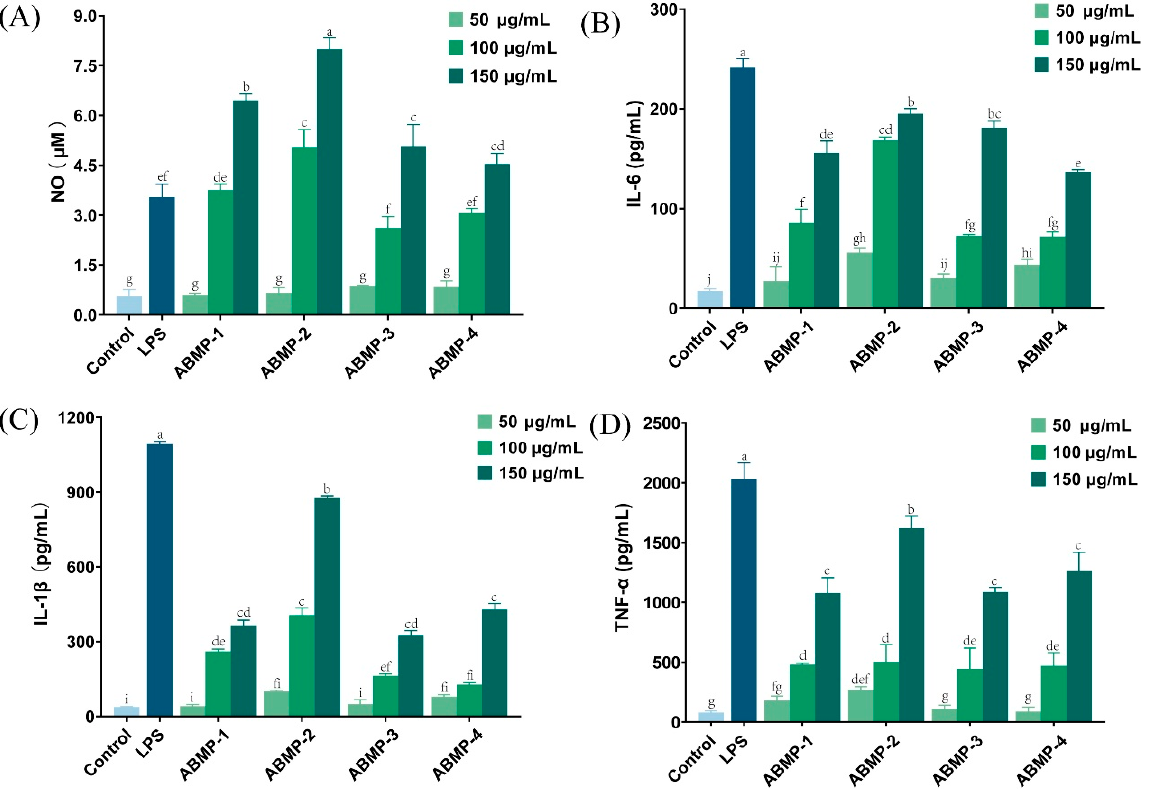
Figure 6. Effects of different fractions of ABMP on the production of NO and cytokines. ( A ) NO; ( B ) IL-6; ( C ) IL-1 β ; ( D ) TNF- α . Mean values marked with different letters (a, b, c, d, etc.) were significantly different ( p < 0.05).